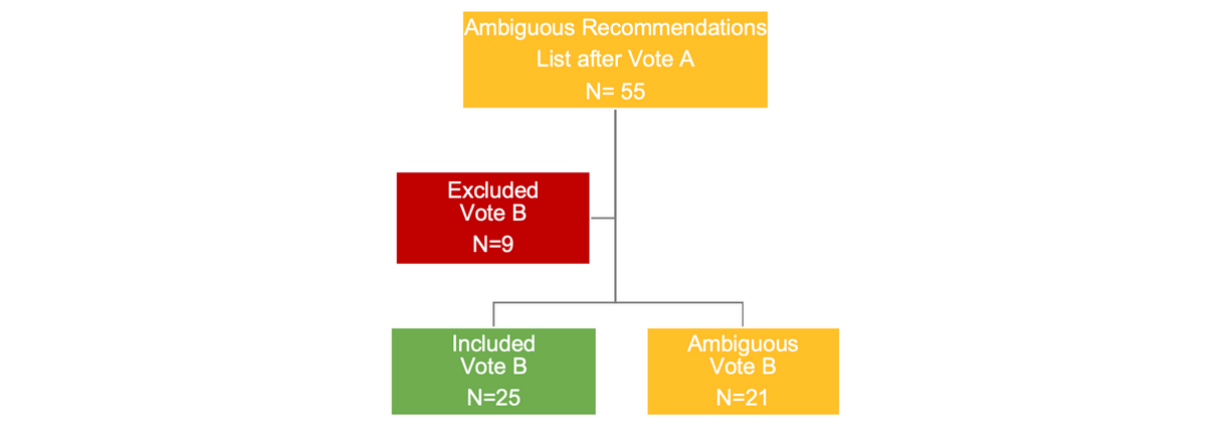
Figure 2. Results from vote B.